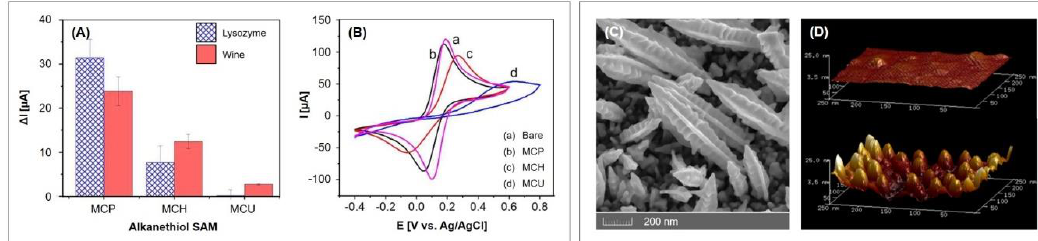
Figure 8. Left: Characterization of 3-mercapto-1-propanol (MCP), 6-mercapto-1-hexanol (MCH), and 11-mercapto-1-undecanol (MCU) monolayers: ( A ) nonspecific binding of lysozyme (10 mg/mL) and wine (diluted 100 times); ( B ) voltammogram. Adapted with permission from the authors of [61], copyright 2019, John Wiley & Sons. Right: ( C ) Field emission scanning electron microscopy image of the fern-leaf-like gold nanostructures, obtained by electrodeposition of AuNPs and PEG 6000. Reproduced with permission from the authors of [80], copyright 2019, Elsevier. ( D ) Atomic force microscopy image of gold electrode before and after AuNPs immobilization onto amino-undecanethiol SAM.